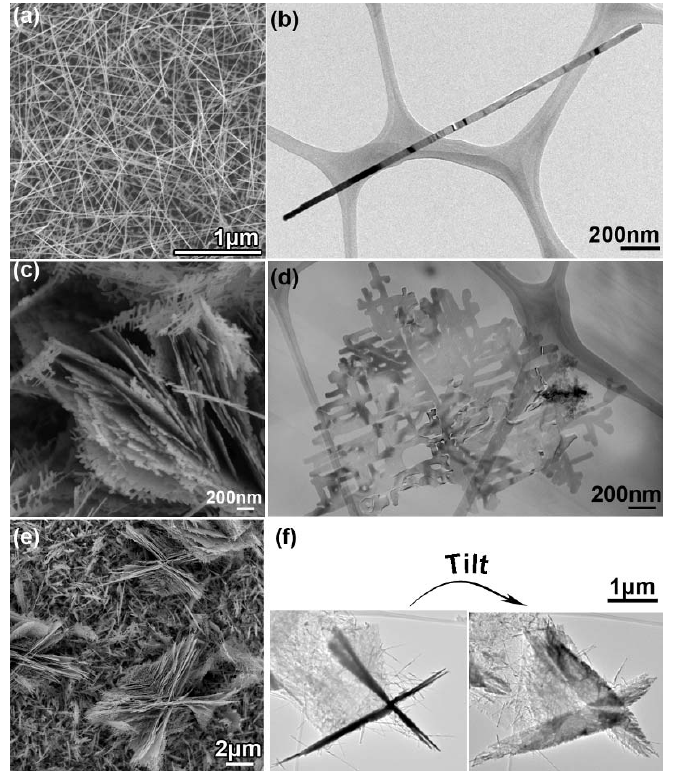
Figure 5. TiSi nanostructures of varying complexities [25]. (a,b) 1D C54-TiSi 2 nanonets. (e,f) 3D C49-TiSi (c,d) 2D C49-TiSi 2 SEM and TEM images, respectively. Reproduced with permissions from American Chemical Society .